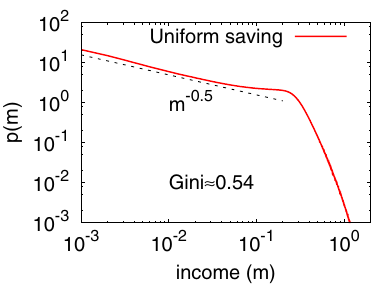
Fig. 7. The distribution of income when the saving propensity (cid:1) i are random variables among the agents taken from a uniform distribution in